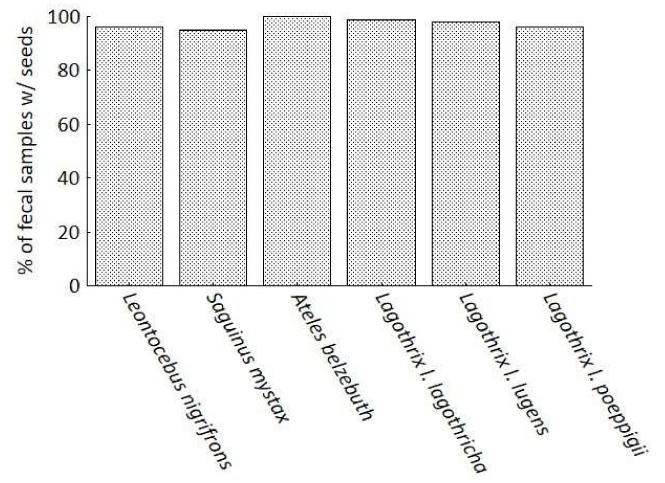
Figure 2. Percentage of fecal samples that include at least one seed. Data sources: Leontocebus nigrifrons and Saguinus mystax : [25]; Ateles belzebuth : [26]; Lagothrix l. lagothricha : [27]; Lagothrix l. lugens : [28]; Lagothrix l. poeppigii : [29].